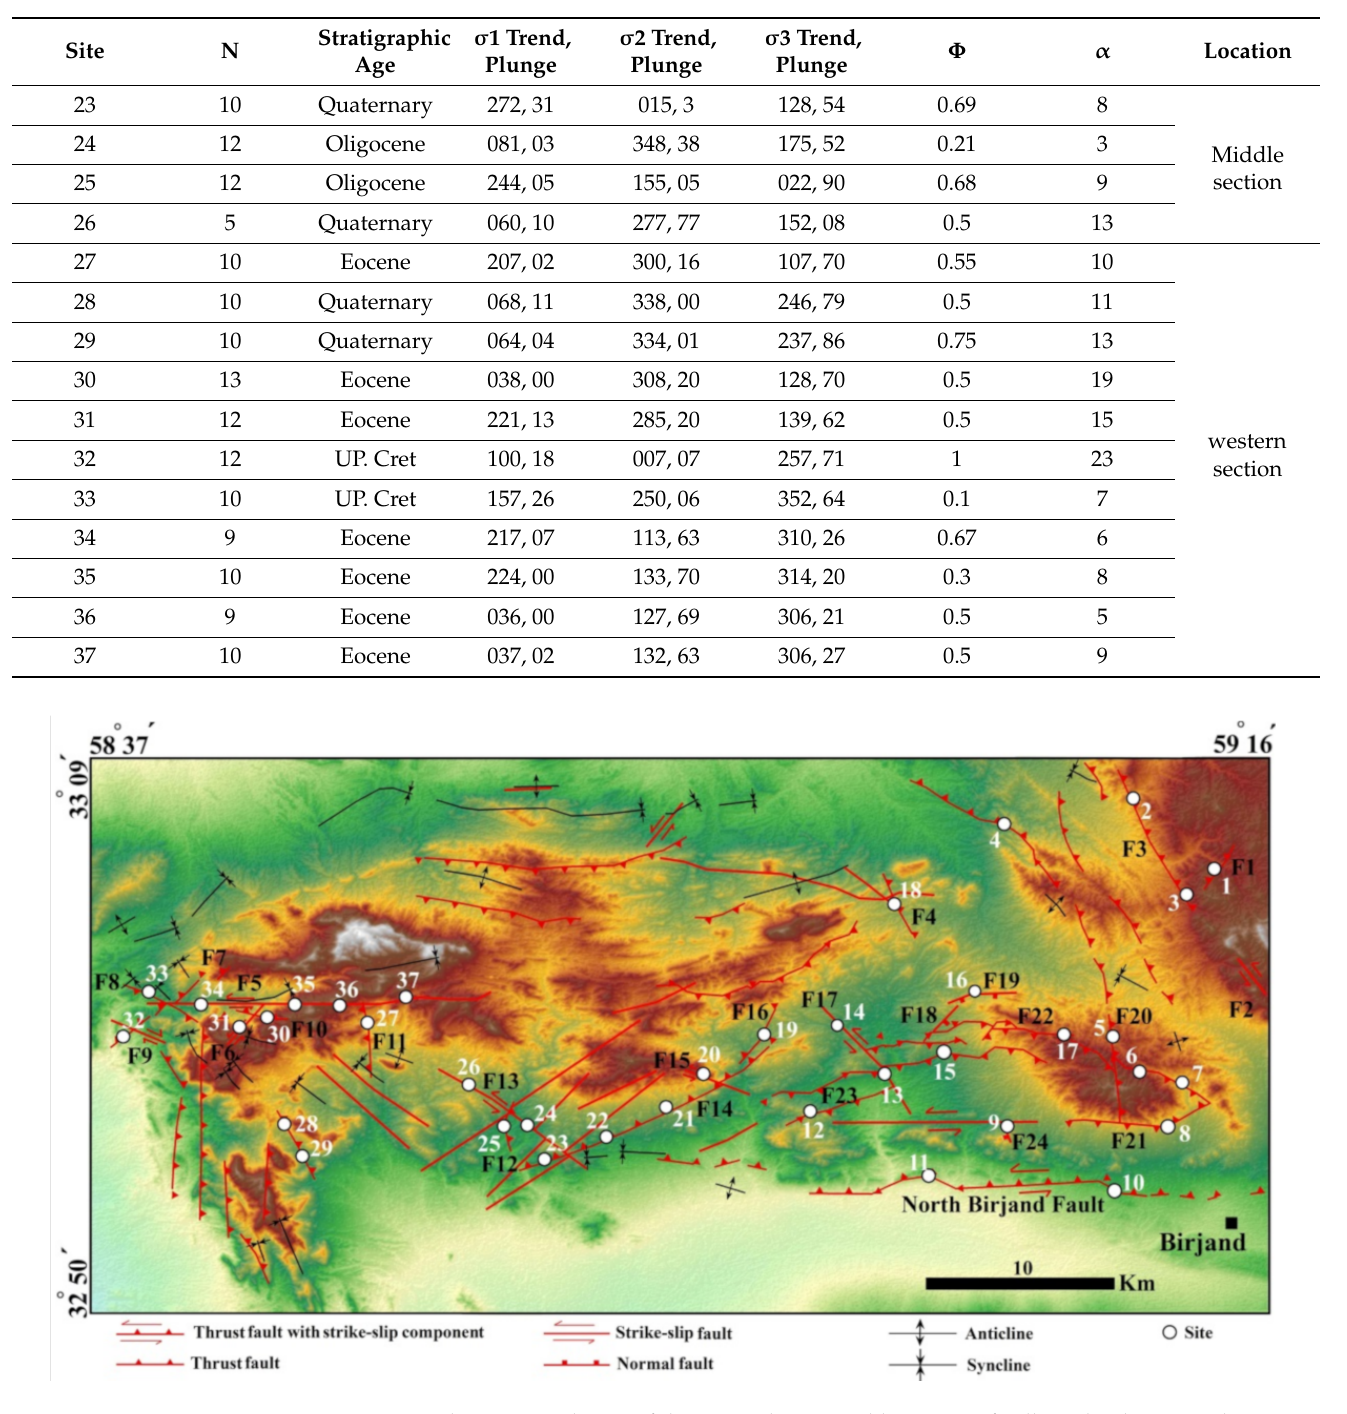
Figure 4. The structural map of the research area and locations of collected paleostress data. F1 to F24 are faults number 1 to faults number